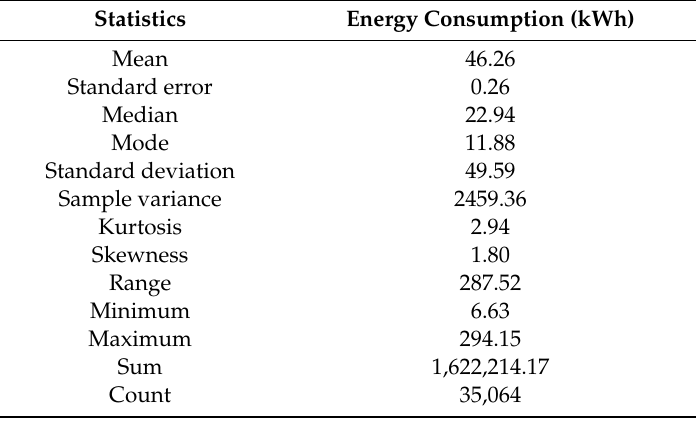
Table 2. Statistics of energy consumption data from industrial building.